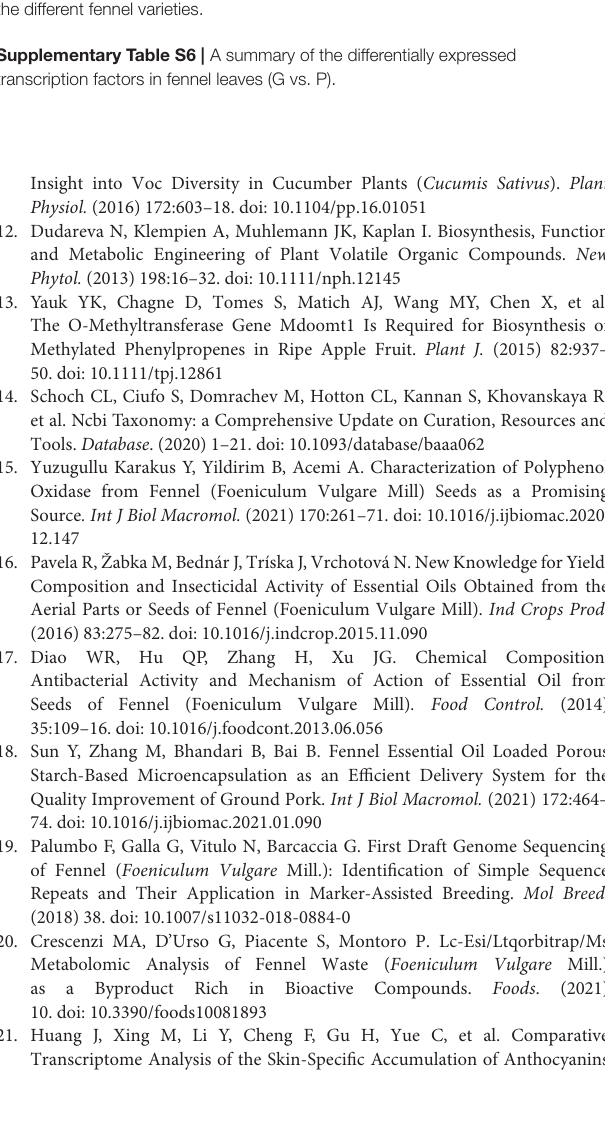
Supplementary Table S3 | Statistical summary of the de novo assembly for the different samples. Supplementary Table S4 | All the DEGs between the different fennel